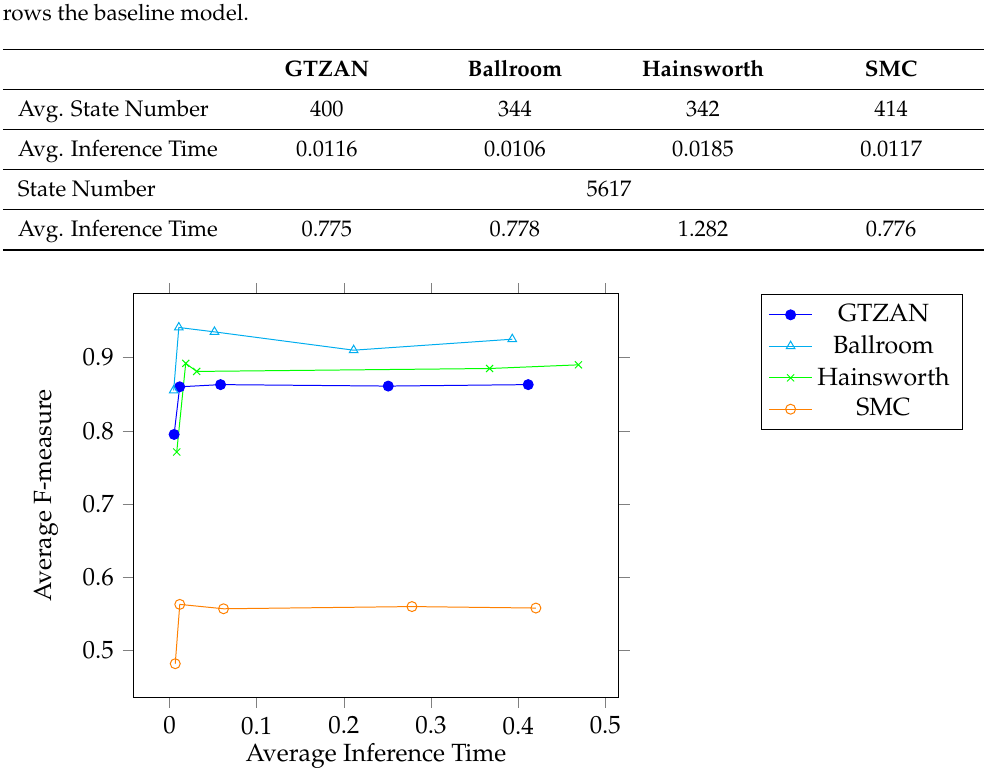
Figure 4. Average F-measure and average inference time on different settings of first k ( k = { 3,5,10,15,20 } from left to right in each line) frenquency components on GTZAN, Ballroom, Hainsworth, and SMC